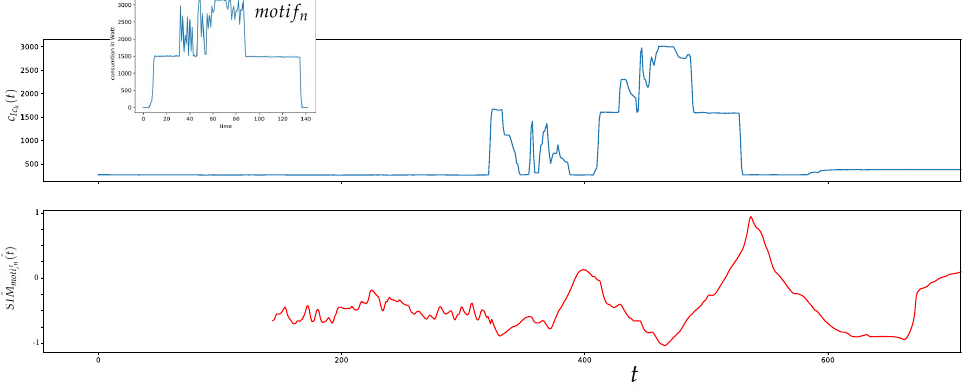
( t ) generated by applying the MASS algo- n